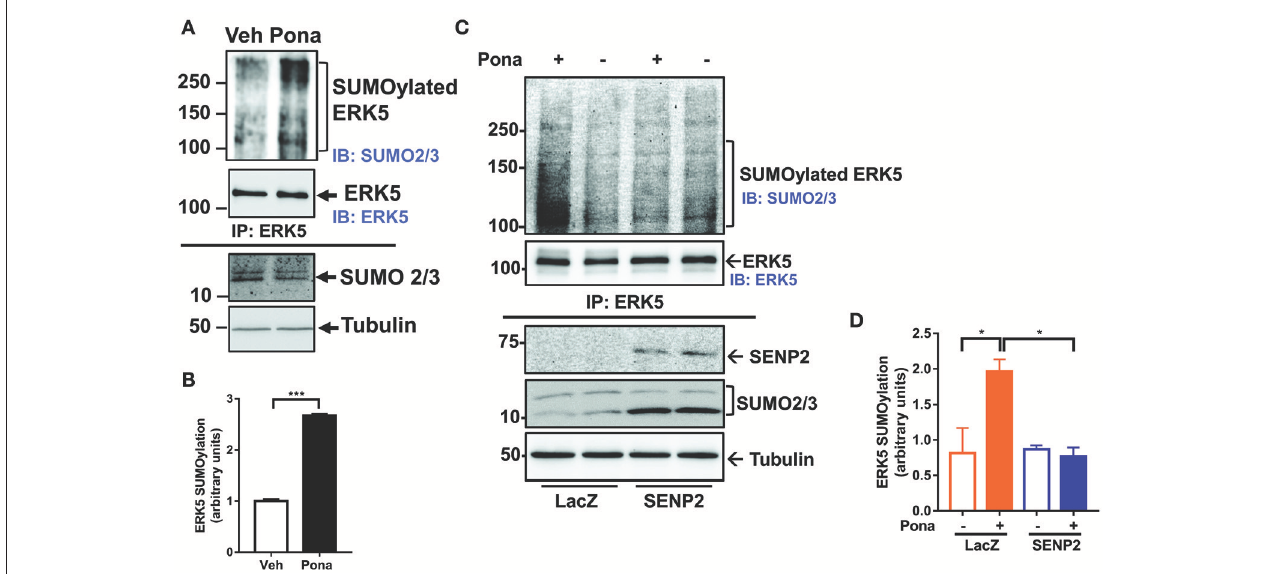
FIGURE 3 | Ponatinib increases ERK5 SUMOylation. (A,B) Western blotting analysis of immuno-precipitated samples to detect SUMOylated ERK5 and ERK5 in HUVECs treated with ponatinib (150nM, 60min). A representative data set of two independent experiments is shown (A) . Densitometric quantification of SUMOylated ERK5. Data is sourced from two independent experiments, each contains 2 technical replicates. Error bars represent mean ± SEM. Statistical significance was assessed using student’s t -test (two-tailed). *** p < 0.001 (B) . (C,D) Western blotting analysis of immuno-precipitated samples to detect SUMOylated ERK5 and ERK5 in HAECs, transduced with Ad-LacZ or Ad-SENP2, treated with ponatinib (150nM, 60min). A representative data set of three independent experiments is shown (C) . Densitometric quantification of SUMOylated ERK5. Data is sourced from three independent experiments, each contains 2 technical replicates. Error bars represent mean ± SEM. Statistical significance was assessed using ANOVA followed by Bonferroni post hoc testing for multiple group comparison. * P < 0.05 vs. control.